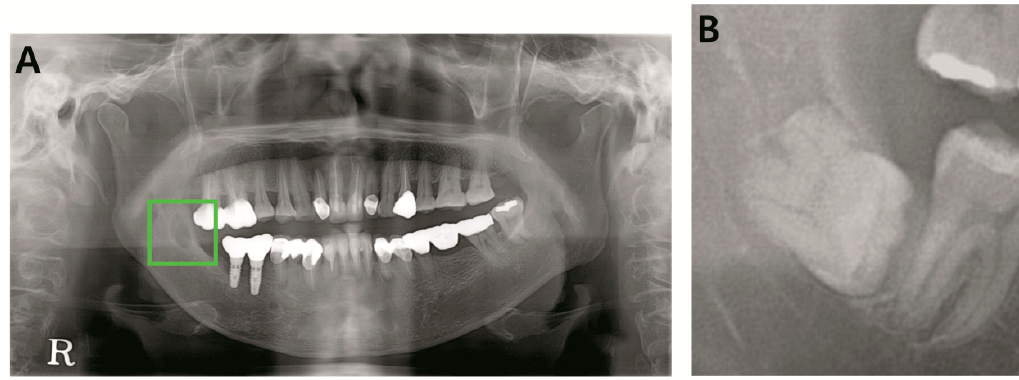
Figure 5. Misclassified early pathology ( A ). Early stage ameloblastoma ( B ). Early stage dentigerous cyst.